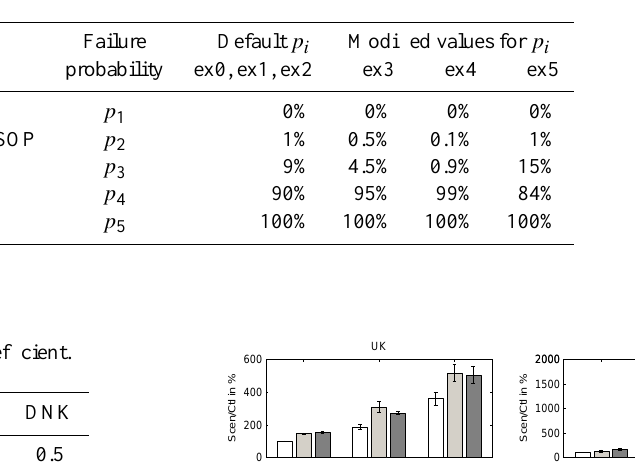
Table 2. Failure probability model. SOP – standard of protection transferred from return periods to meters, CL – crest level in meters.